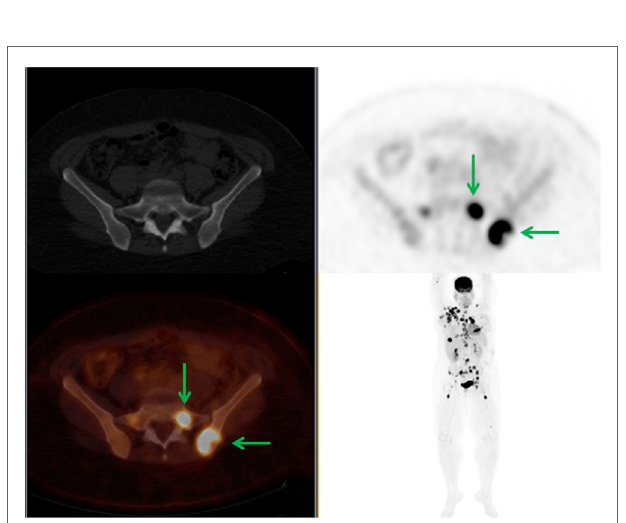
FigUre 3 | a 34-year-old female diagnosed with right breast cancer . 18F-FDG PET demonstrated widespread disease with PET-positive CT-negative SM. The FDG-avid left iliac bone and sacral lesions demonstrated no bone changes in the CT (green arrows). In this case, there was no change in staging; however, BMA was offered.